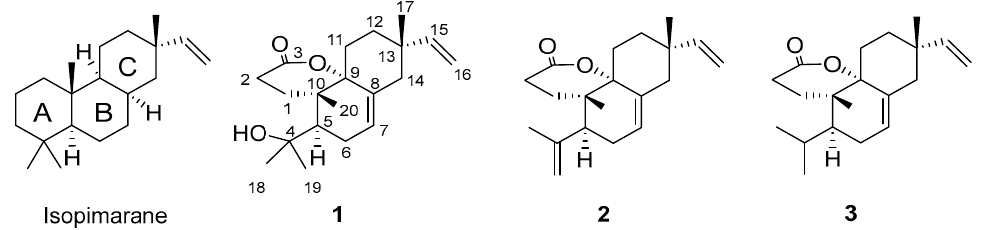
Figure 1. Chemical structures of isopimarane skeleton and compounds 1 – 3